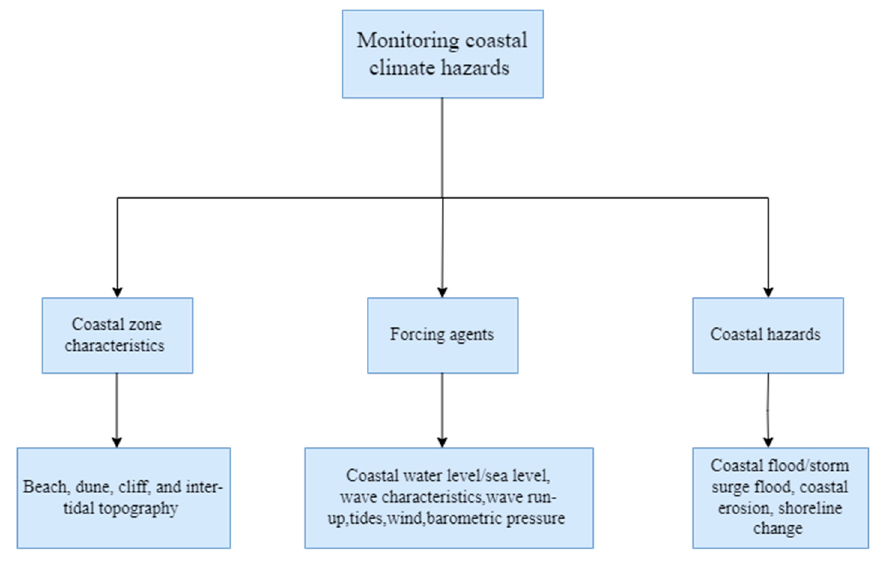
Figure 3. The coastal zone characteristics, metocean variables, and coastal hazards monitored by the sensors reviewed in this paper.